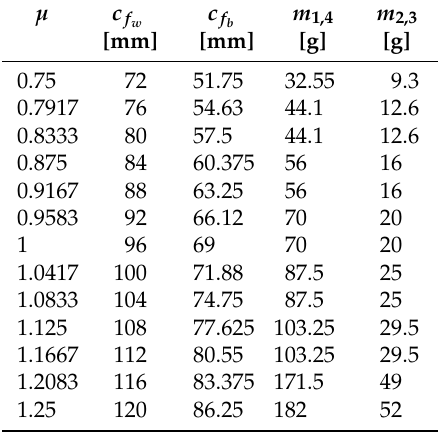
Figure 4. Actuator masses and their values with a cubic polynomial fit. Table 1. Chord lengths and actuator masses for the chosen µ